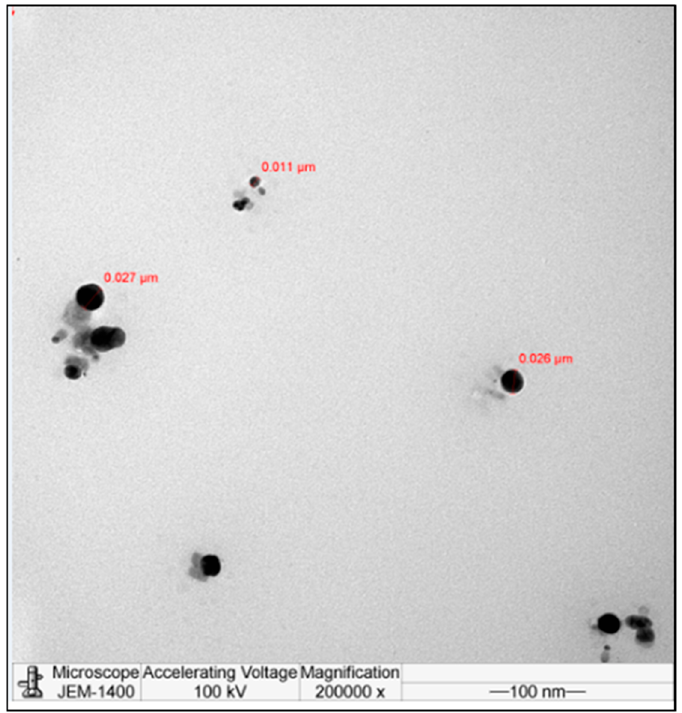
Figure 4. TEM micrograph of AgNPs prepared with aqueous A. nilotica pod extract.